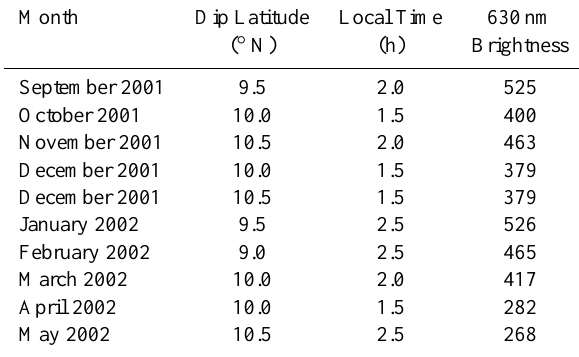
Table 2. Post-midnight maximum